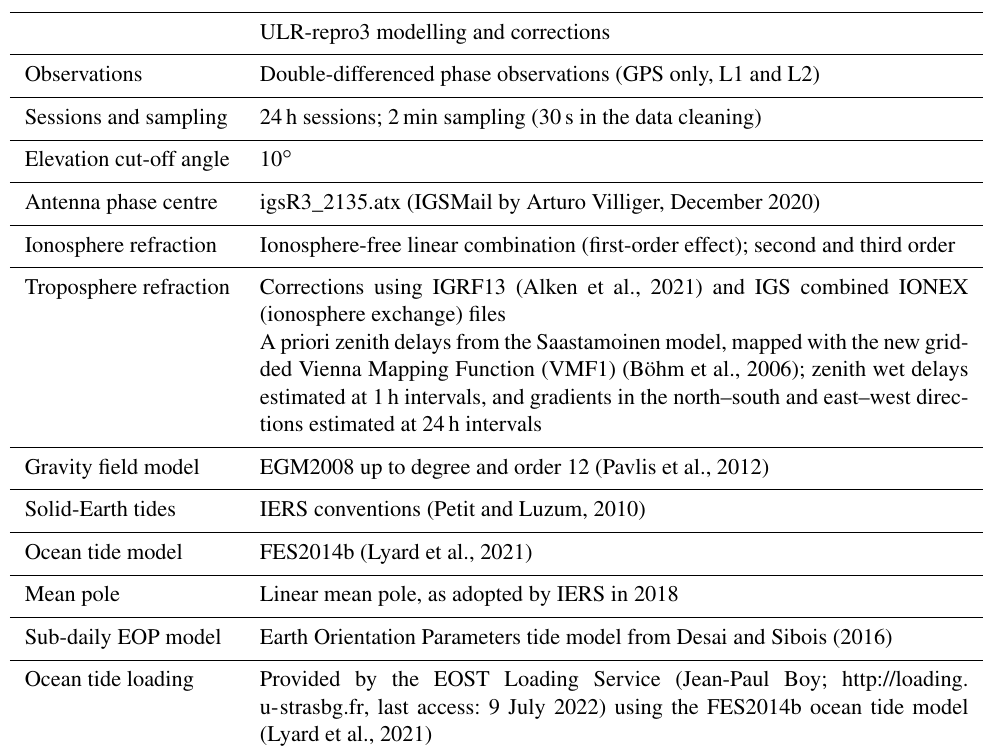
Table 1. Main features of the GNSS data analysis strategy adopted for ULR-repro3 following the IGS recommendations (http://acc.igs.org/ repro3/repro3.html, last access: 5 January